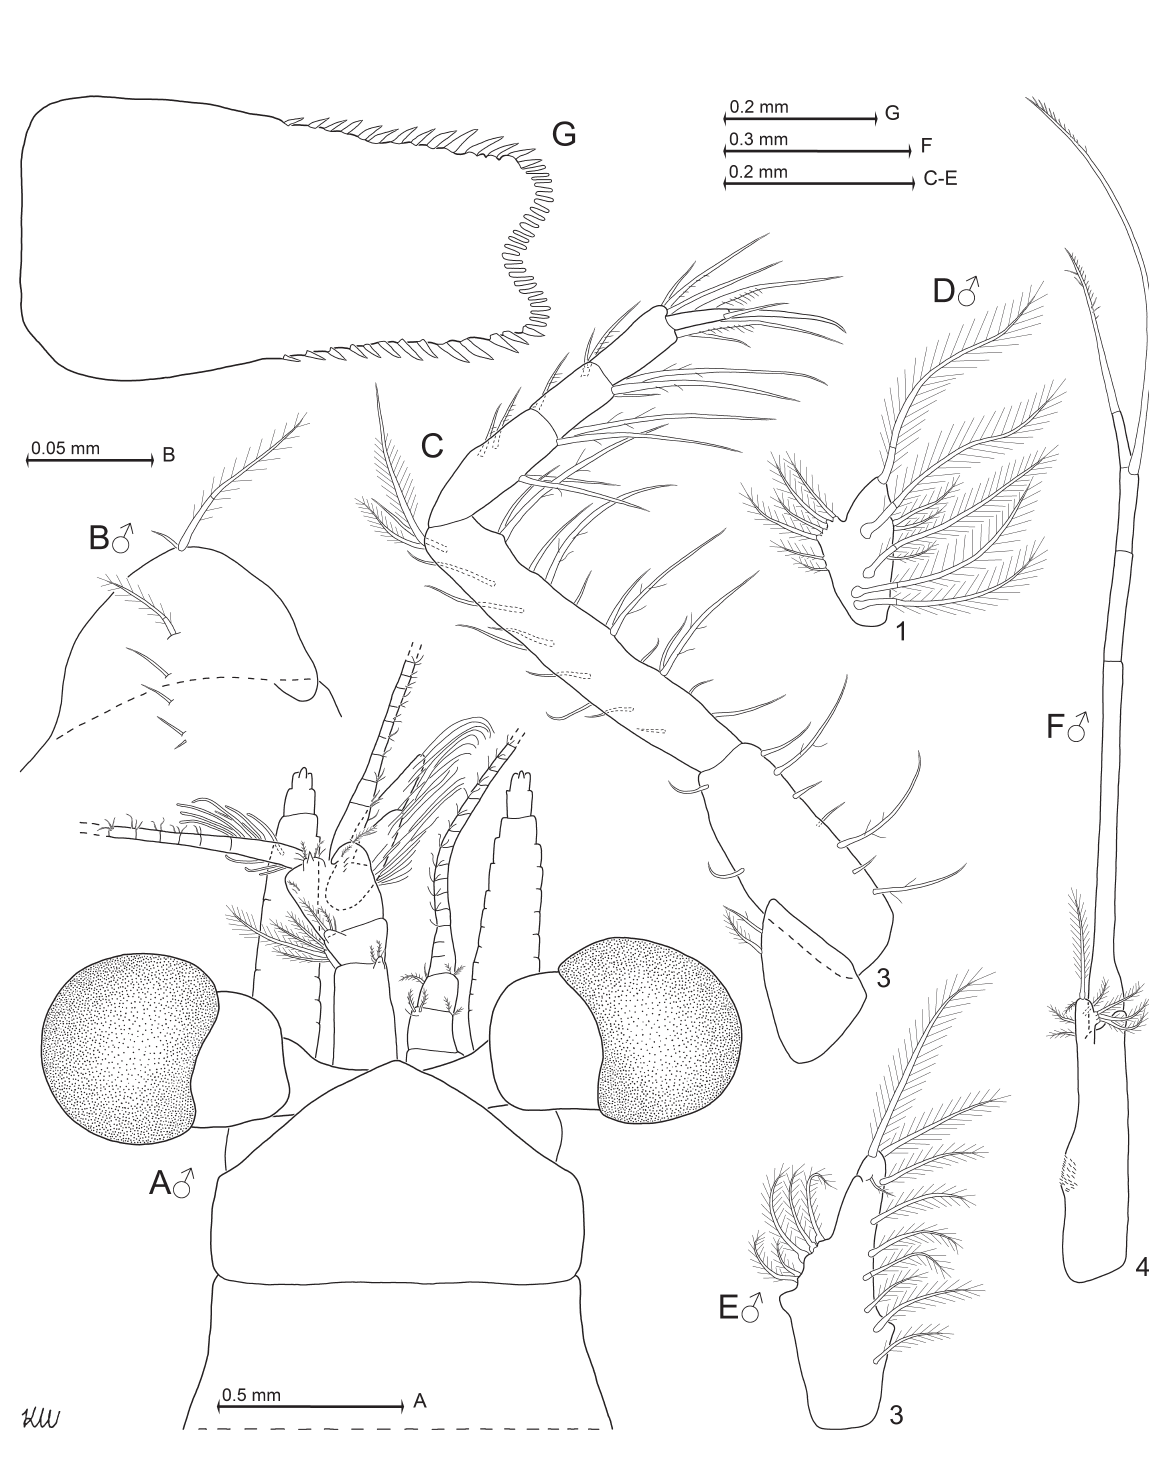
Fig. 1. Mysidium gracile (Dana, 1852), off Cabo Frio in Brazil, non-types. A–B . ♂, 5.6 mm body length. C, G . ♂, 5.3 mm. D–F . ♂, 5.2 mm. A . Cephalic region, right antennula and setae of antennal scale omitted. B . Mediodistal extension of right antennular trunk, dorsal. C . Third thoracic endopod, caudal. D – E . Pleopods 1 and 3, rostral. F . Pleopod 4, caudal. G .